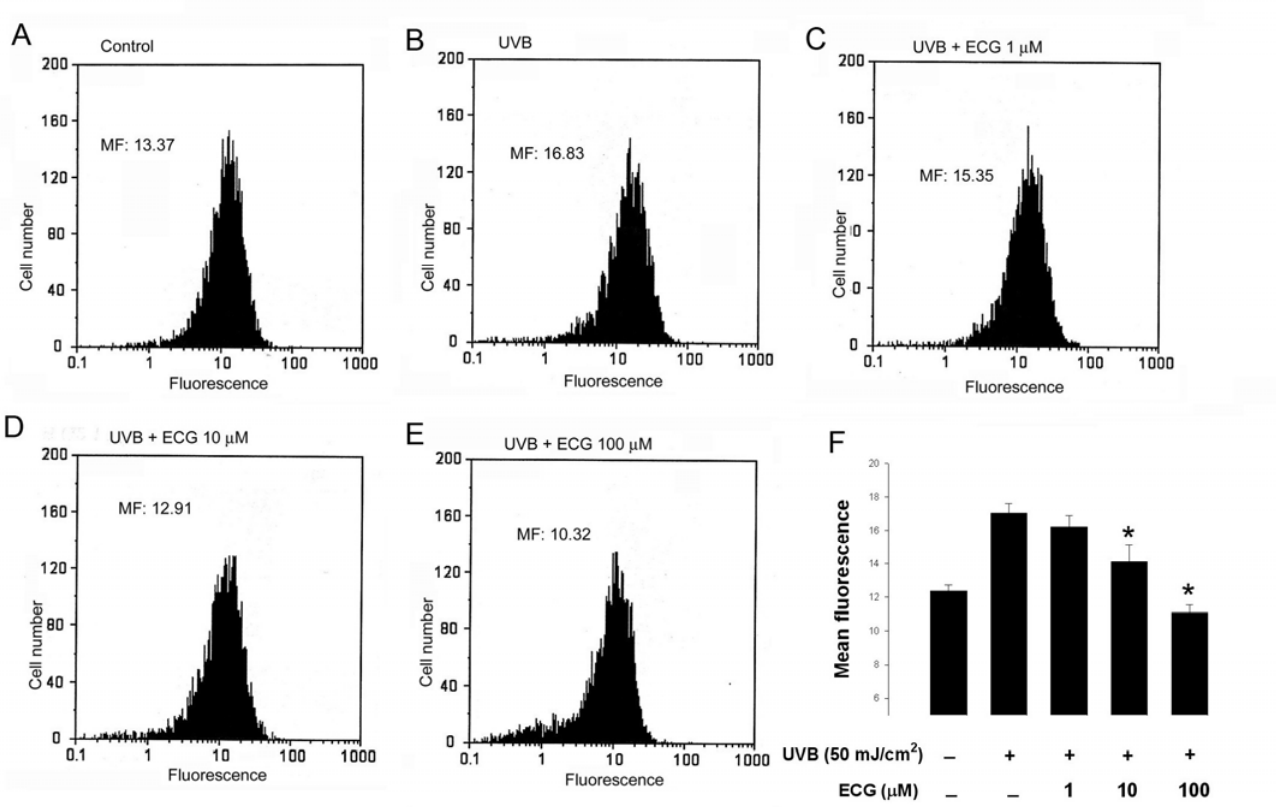
O production in 2 2